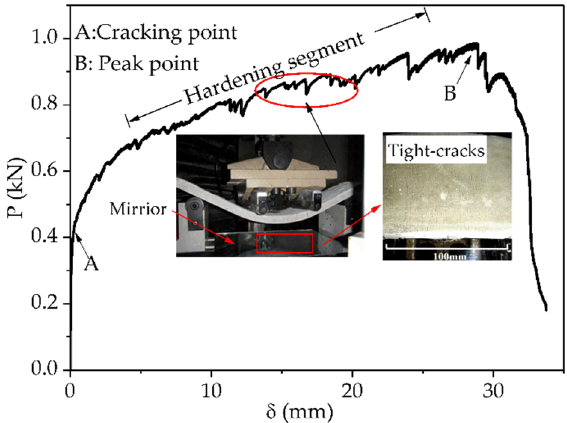
Figure 4. Representative load versus mid-span deflection (P– δ ) curve of the control specimen, showing the classical strain-hardening and super-toughness characteristics of polyvinyl alcohol fiber reinforced engineering cementitious composites (PVA-ECCs).